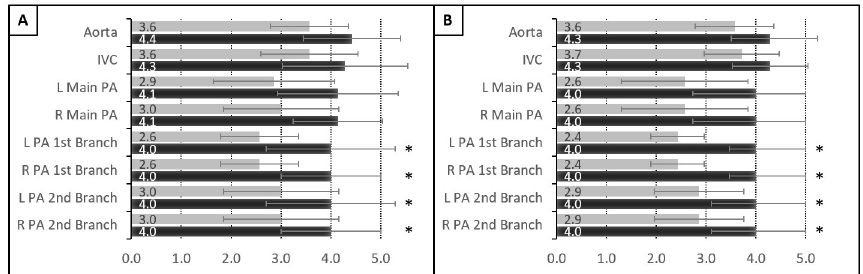
Fig 4. Trainees’ subjective rating on the discernibility of pulmonary vasculature on CT images before and after CF800 injection. (A) Rabbit (B) Pig (Scale 1–5; Mean ± SD; � p < 0.05). Legend—grey: before CF800 injection; black: after CF800 injection.